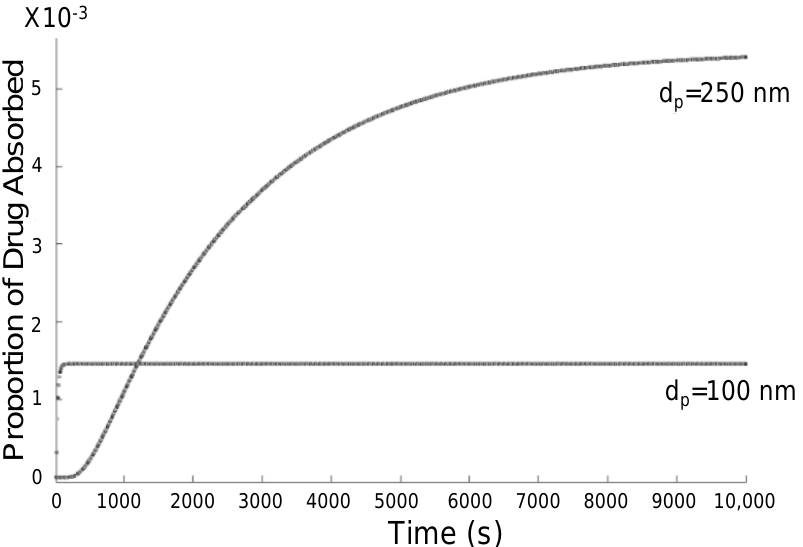
Figure 15. Proportion of total injected drug absorbed through olfactory epithelium over